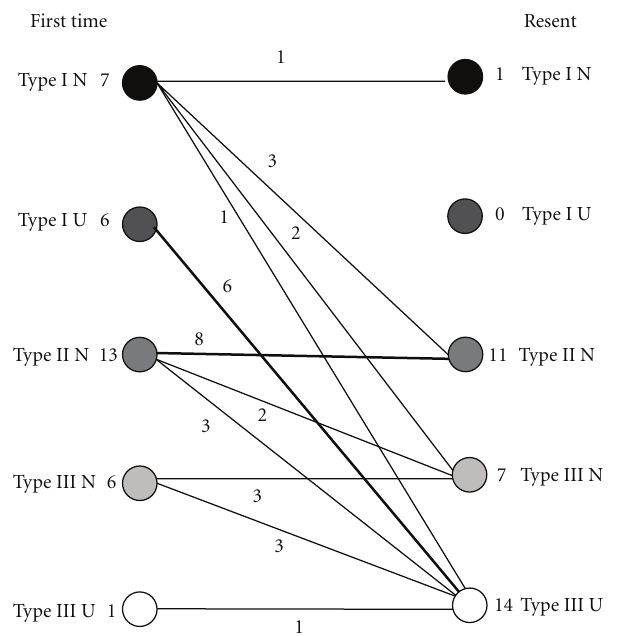
Figure 6: The changes in type during the course of the study for patients who could be observed for 2 years or more.